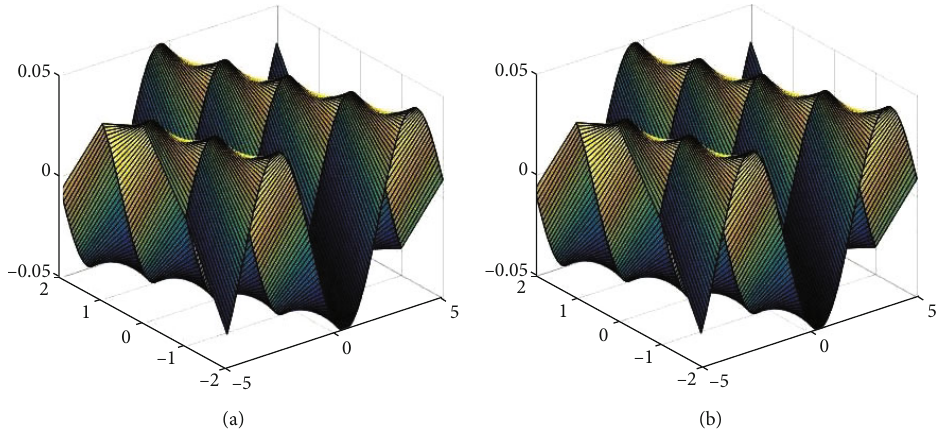
Figure 4: (a) Actual and (b) SDM/q-HATM result of ν ð χ , ξ , I Þ at δ = 1 .